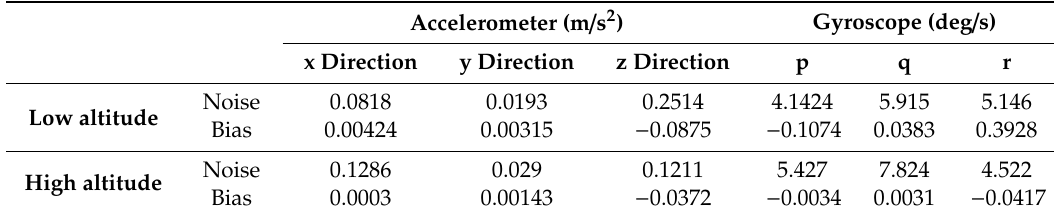
Table 12. The statistics of IMU measurement noise and